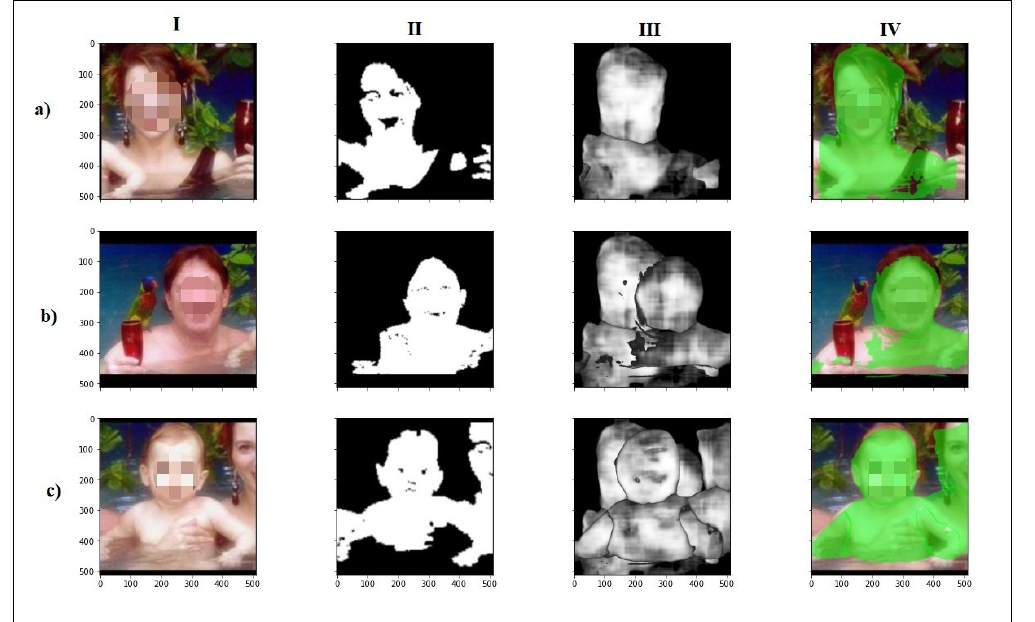
Figure 15. Results of processing an image containing more than one person and showing the final result: (I) input, (II) ground truth, (III) prediction, and (IV) prediction mask overlaid on